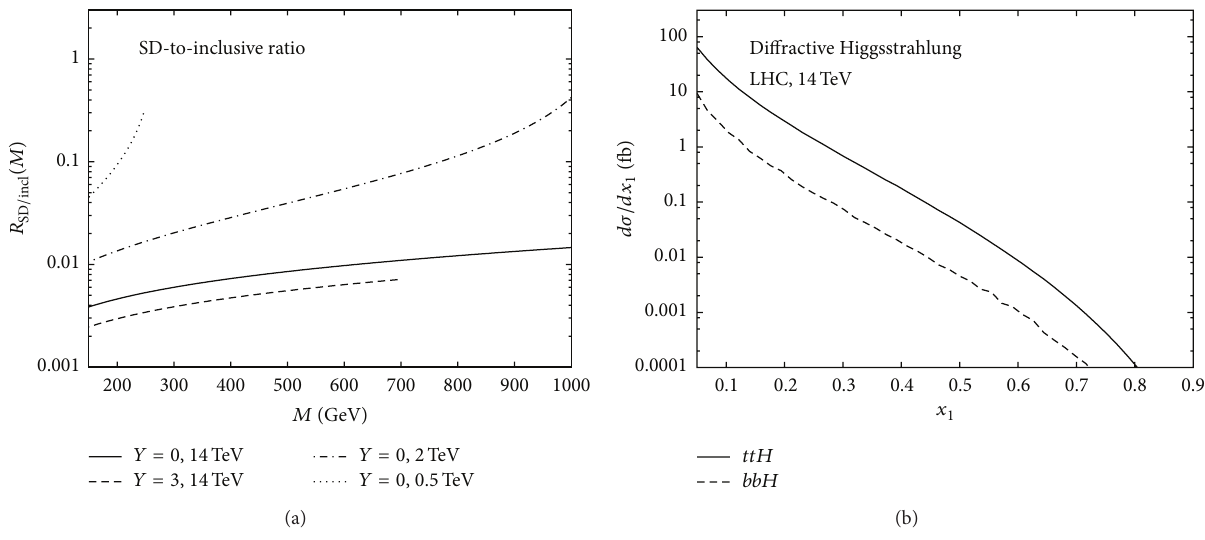
Figure 16: The SD-to-inclusive ratio 𝑅(𝑀) as a function of 𝑄𝑄𝐻 invariant mass 𝑀 for different c.m. energies √𝑠 = 0.5, 2,14 TeV (a) and the differential cross section 𝑑𝜎/𝑑𝑥 1 of the SD Higgsstrahlung off 𝑡𝑡 and 𝑏𝑏 pairs for √𝑠 = 14 TeV (b)